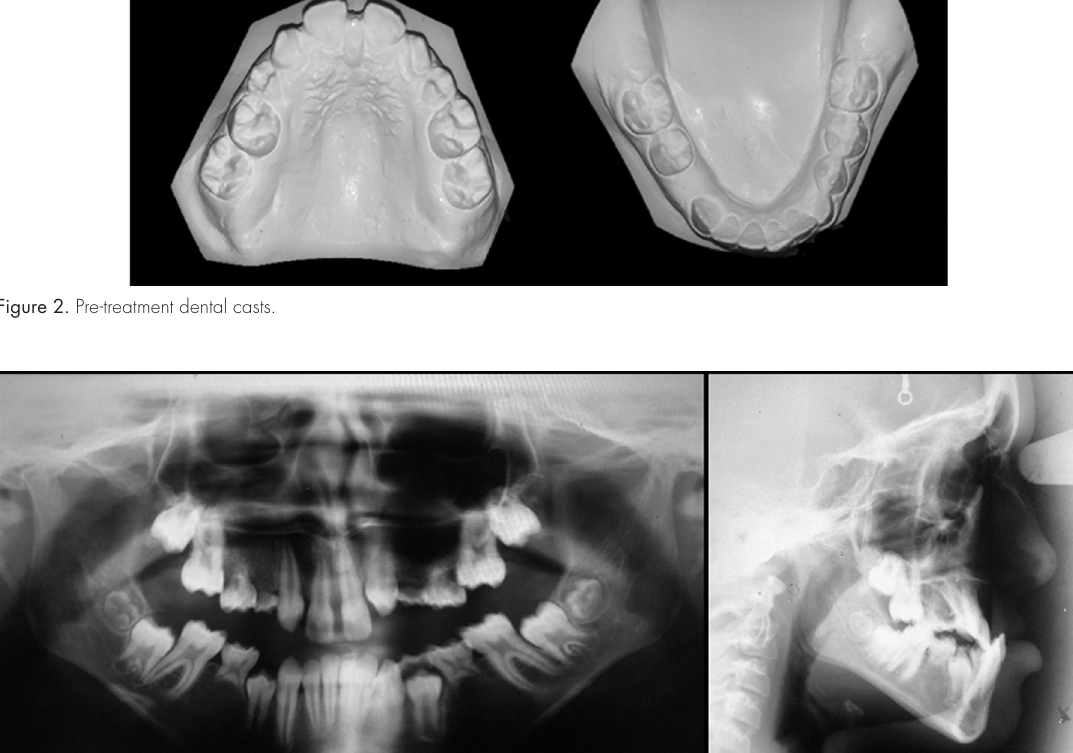
Figure 3. Pre-treatment lateral cephalogram and